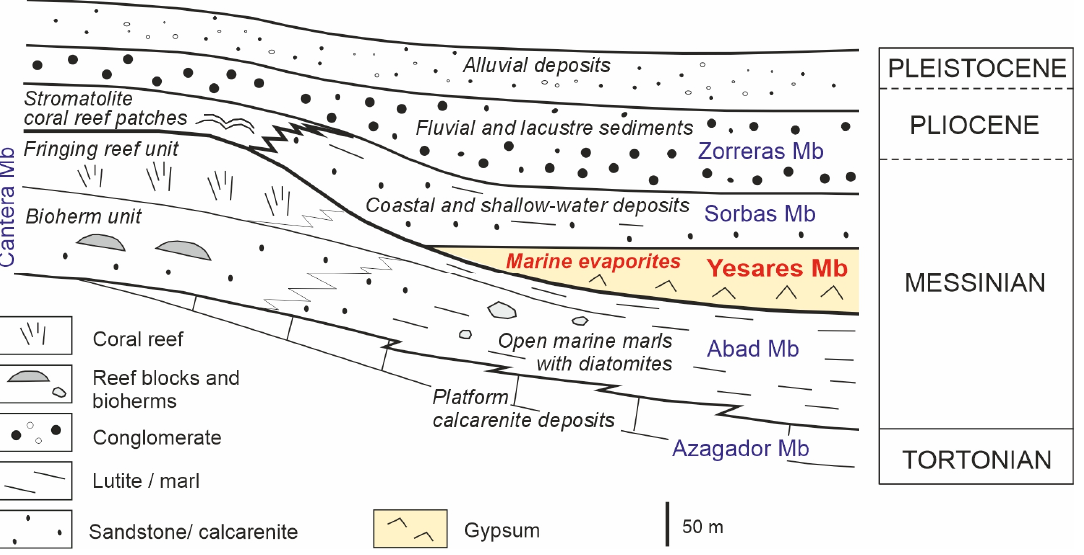
Figure 3. Messinian stratigraphic framework for the Sorbas Basin (modified from Martín and Braga, 1994 [27]).